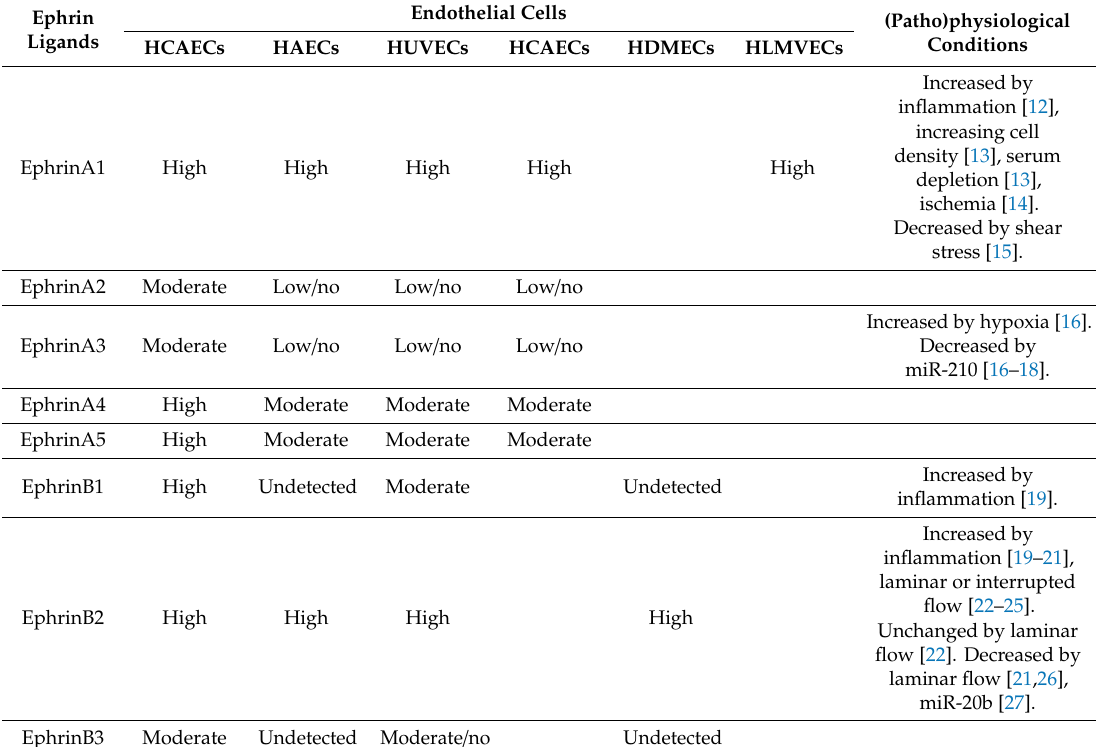
Table 1. Ephrin ligand expression in endothelial cells.